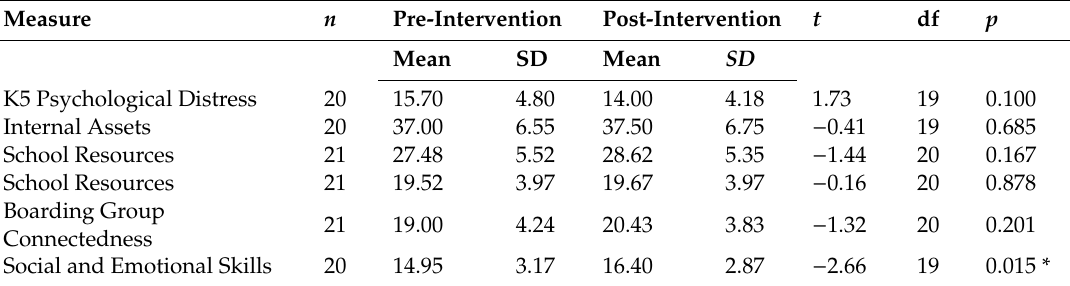
Table 3. Student survey component scores, pre and post